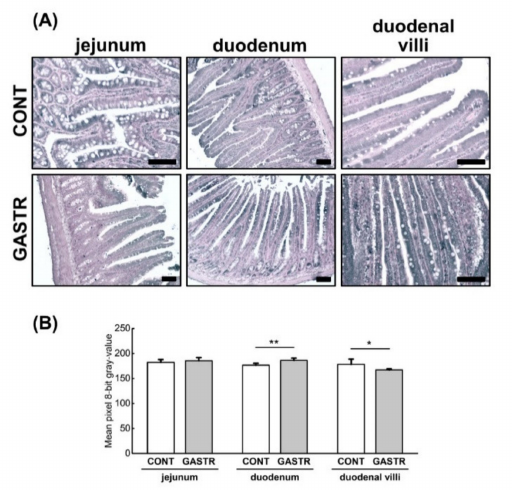
Figure 8. ( A ) Representative photomicrographs of the immunohistochemical reactions for marvelD3. Sections were developed in 3,3 (cid:48) -diaminobenzidine tetrahydrochloride with metal enhancer; counter- staining was performed with Nuclear Fast Red. All the scale bars represent 100 µ m. ( B ) The intensity of expression of marvelD3, measured by the quantitative assessment of mean pixel intensity values in the photomicrographs converted to 8-bit grayscale images. Scale from 0 (white pixel) to 255 (black pixel); the lower the pixel value, the higher the intensity of immunohistochemical reaction. Graph shows mean ± standard error. Significance was established using a two-tailed Student’s t -test (normally distributed data), Welch’s test (normally distributed data with unequal variances) or the Mann–Whitney test (for pairwise comparisons with at least one non-normally distributed dataset); * p < 0.05; ** p <